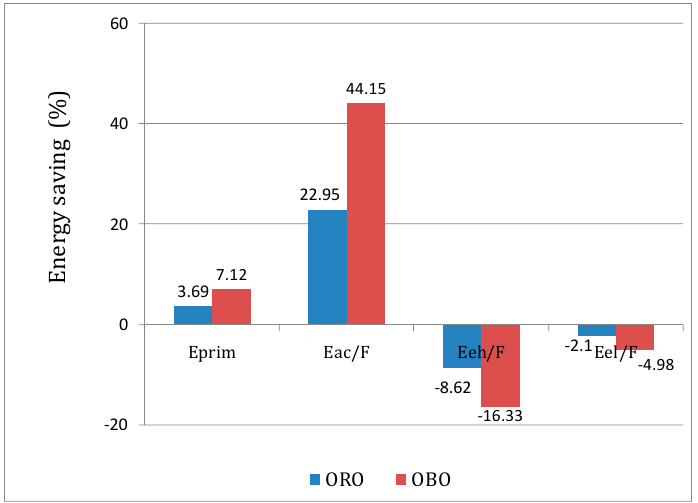
Figure 9. Primary and specific final energy savings in analyzed buildings (in percents, compared to basic building without overhangs).